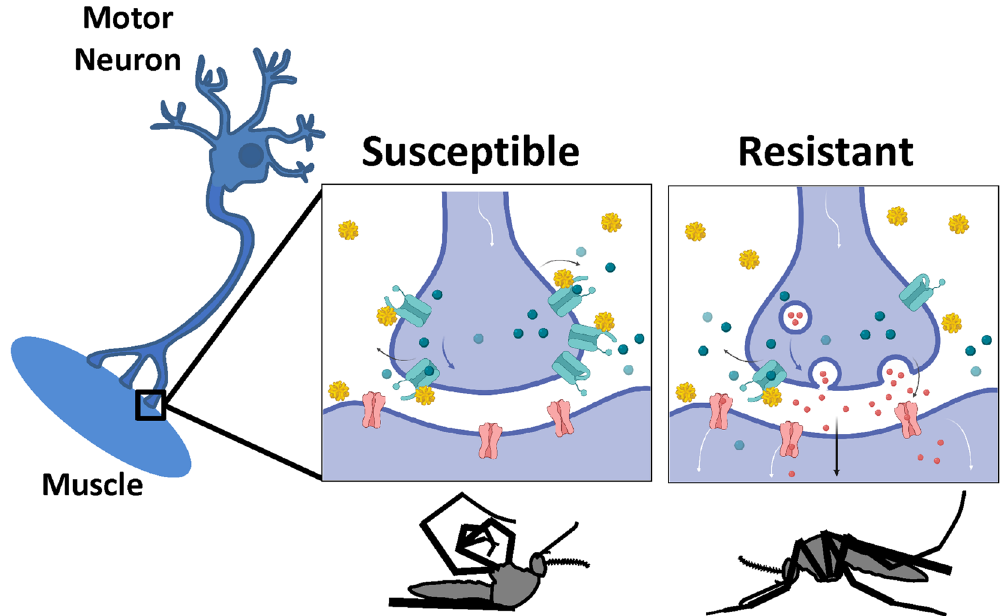
Figure 5. Model depicts differential responses to permethrin treatment in motoneurons of susceptible and resistant mosquito populations. Susceptible mosquito motoneurons depolarize upon permethrin binding to VGSC, leading to cessation of neurotransmitter release, paralysis and possibly death (left panel). Vergel resistant mosquitoes, with reduced VGSC transcript and protein levels, have fewer permethrin binding sites on motoneurons, and therefore less depolarization and subsequent toxicity. Permethrin molecules are shown in bright yellow spheres. Aqua molecules depict VGSC. Red, aqua and blue circles depict neurotransmitters. Pink receptors depict neurotransmitter receptors. Images drawn in Biorender (Biorender.com), with